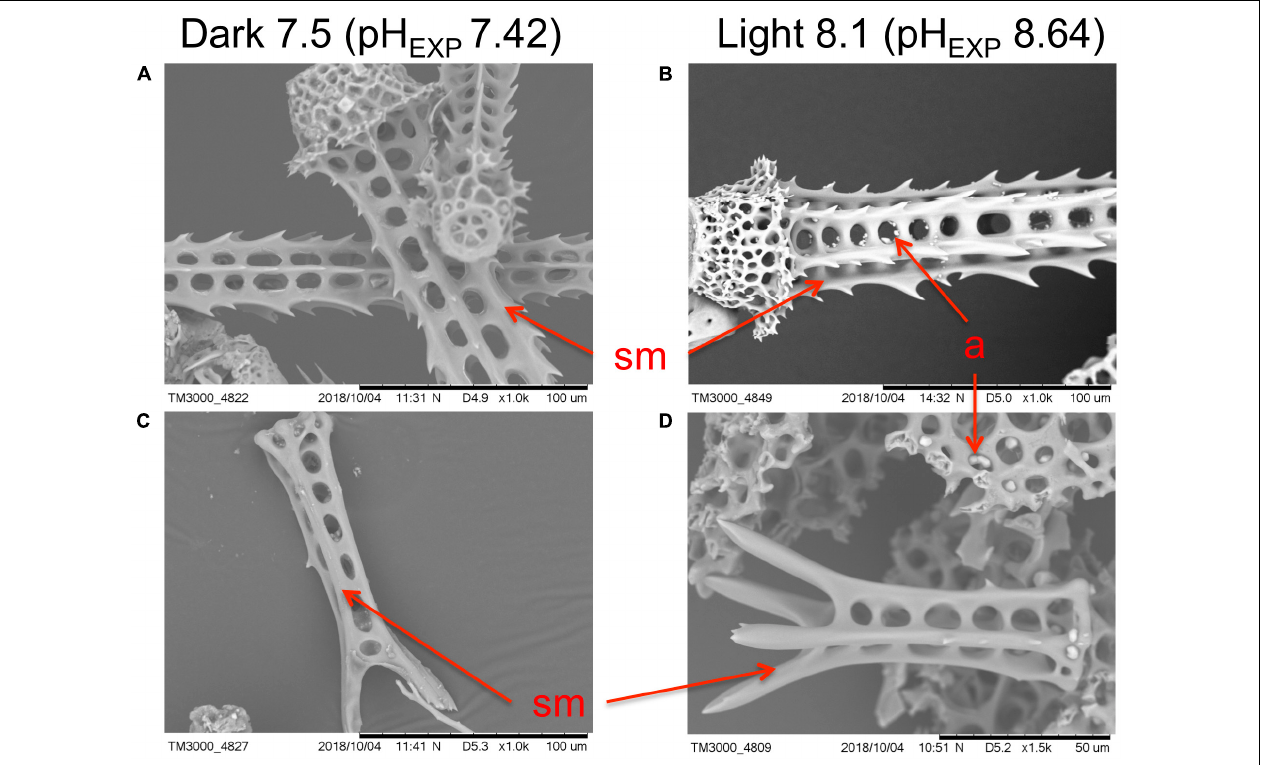
FIGURE 5 | Examples of scanning electron micrographs of Pseudechinus huttoni juveniles reared in the dark at bulk seawater pH 7.5 (pH EXP 7.42) and in the light at bulk seawater pH 8.1 (pH EXP 8.64), for 4 days post-settlement. Scale bars are (A–C) 100 µ m and (D) 50 µ m, as indicated on SEM micrographs. Micrographs depict (A,B) base and attachment site of adult spines, and (C,D) juvenile spines. sm smooth surface. a artifact (a product of sample preparation for the